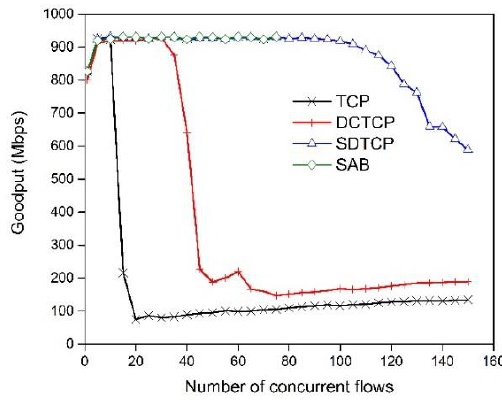
Figure 9. Goodput of SDTCP, TCP, DCTCP, and SAB.